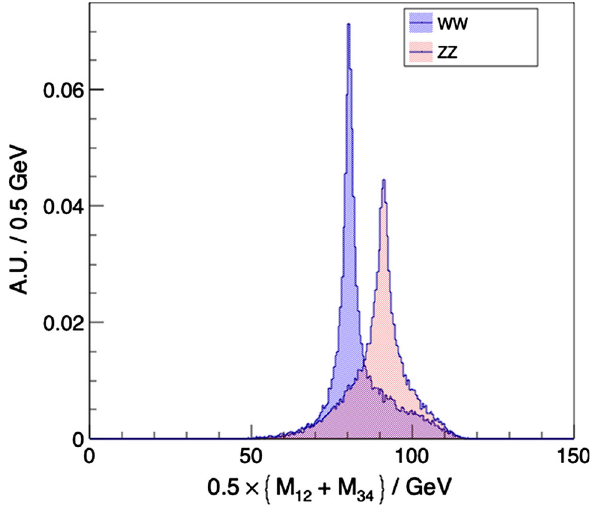
Fig. 7 The GenJet level distributions of 0 . 5 × ( M 12 + M 34 ) of the WW and ZZ events. The overlapping fraction is 52 . 6% ± 0 .